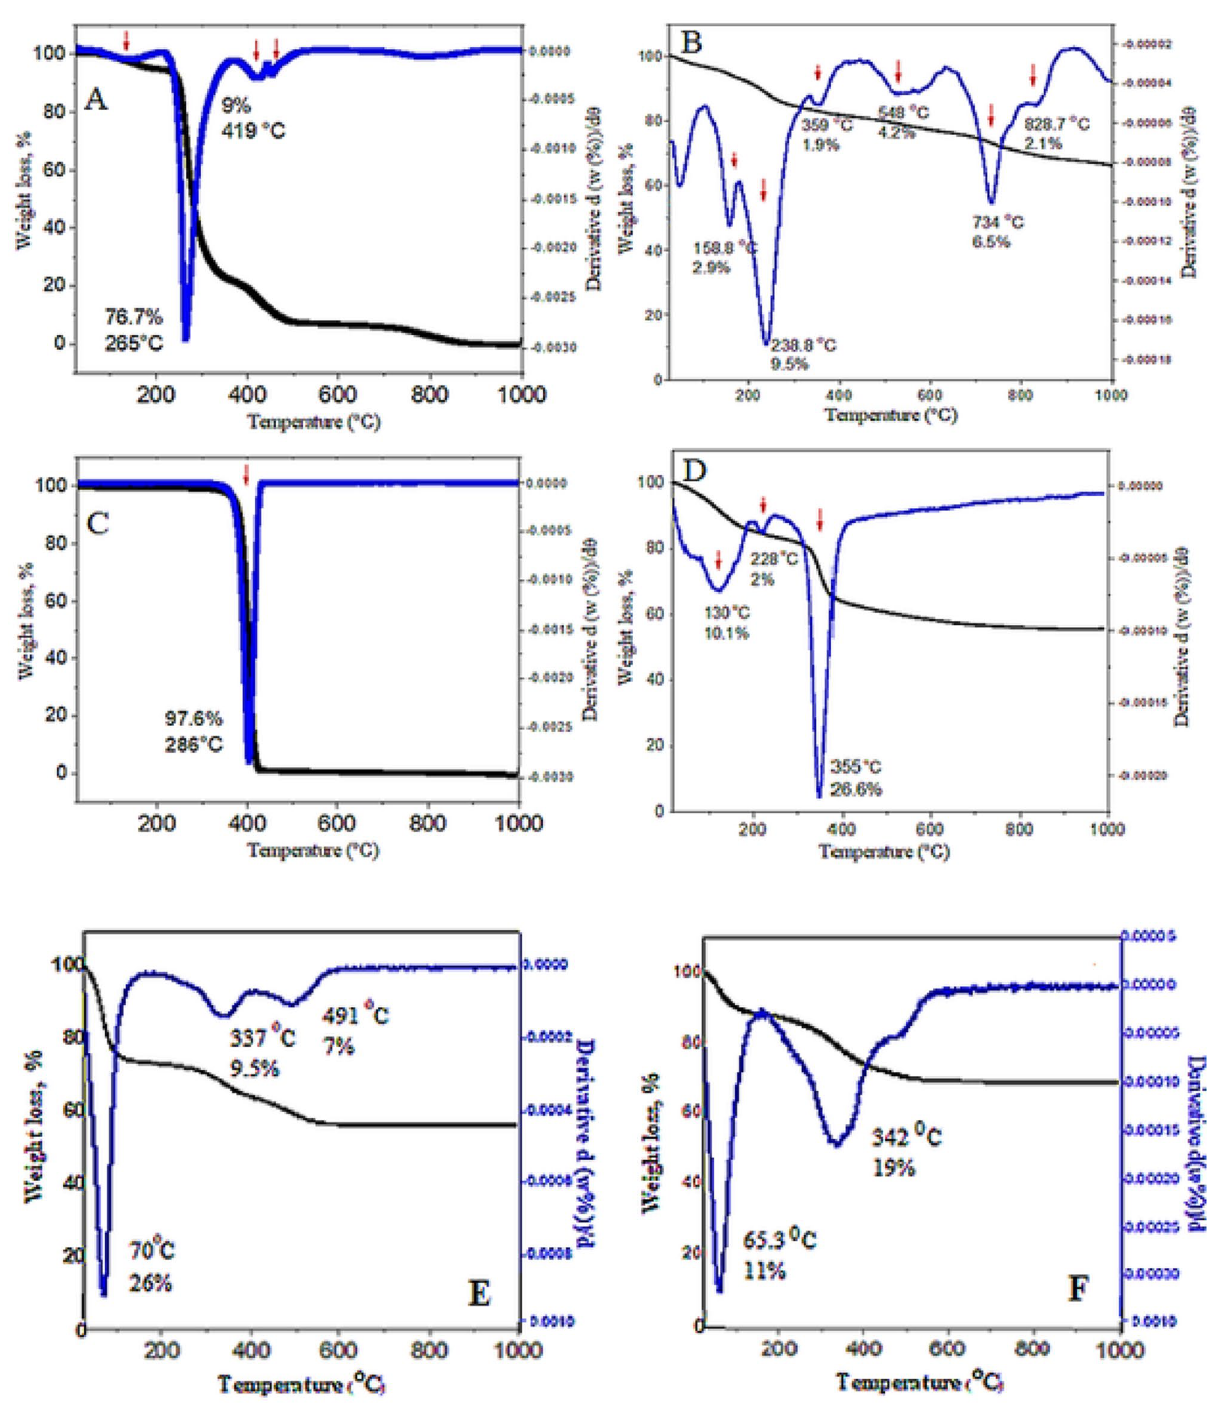
Figure 5. Thermogravimetry analyses of ( A ) pure PVA; ( B ) core–shell nanoparticles (FPVASO-MLDH); ( C ) pure PEG; ( D ) core–shell nanoparticles (FPEGSO-MLDH); ( E ) FPEGSO; ( F ) FPVASO. Note: The red arrows point to the weight